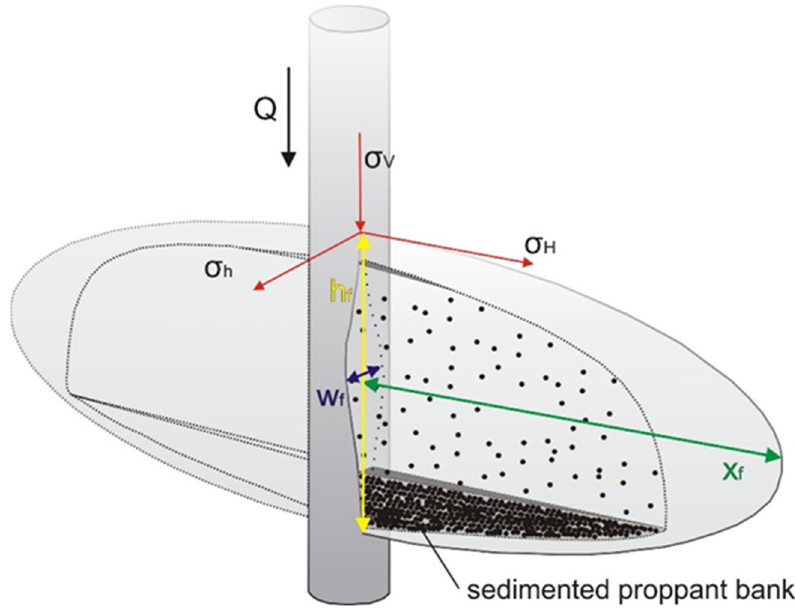
Figure 3. Dimensions of the fracture: x f —length, h f —height, w f —width. Q—flow, σ V —vertical stress, σ H , σ h —horizontal stresses. Based on [18].